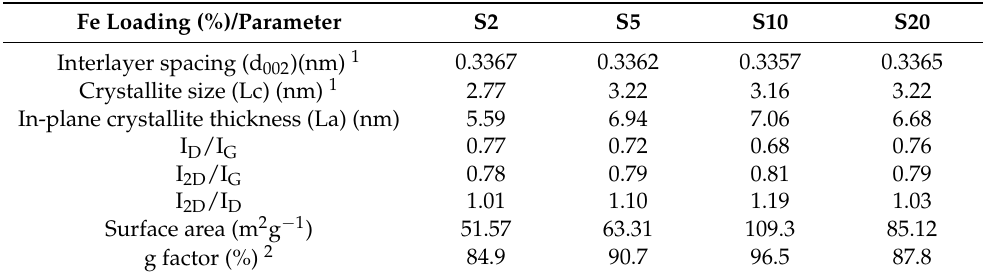
Table 2. Structural properties of composite materials with different Fe-loadings fabricated via microwave-assisted catalytic